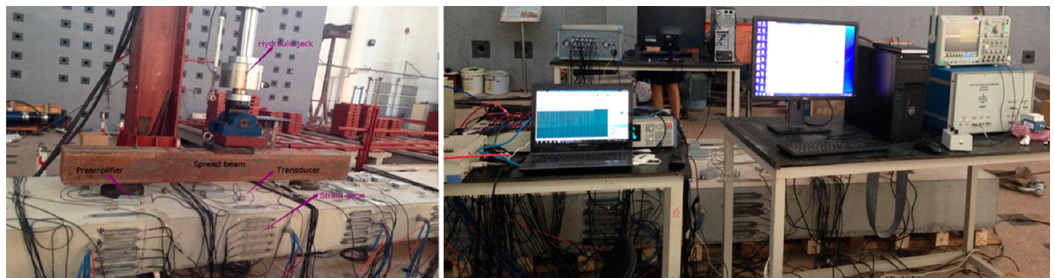
Figure 3. Photographs of ( left ) experimental setup and ( right ) excitation and measurement